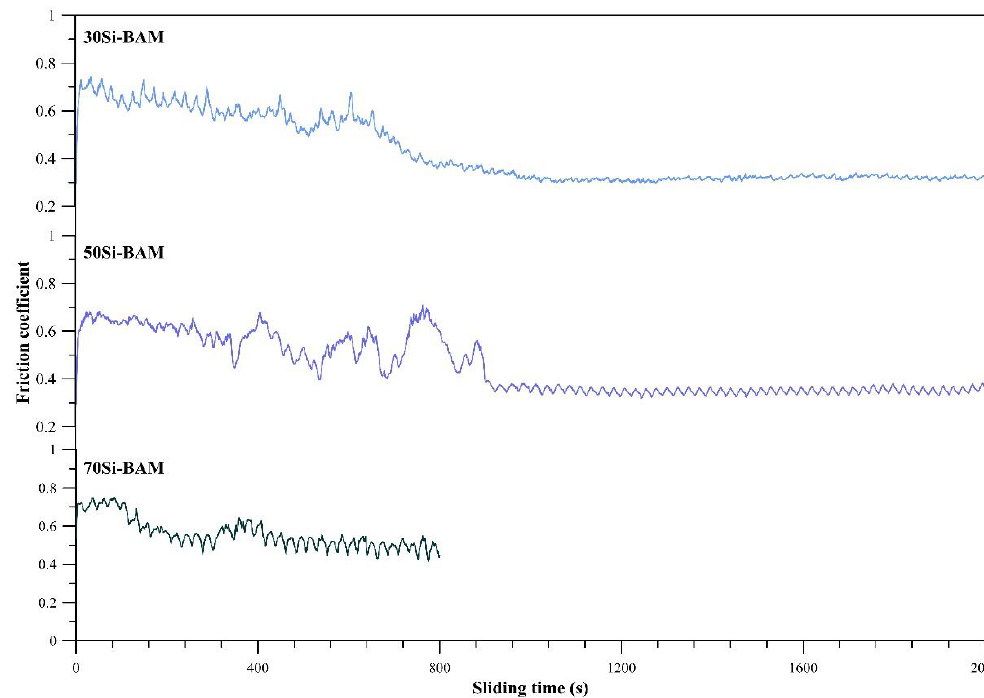
Figure 5. Variation of the friction coefficient of the obtained specimens. Table 4. Friction coefficient and wear rate of the sintered